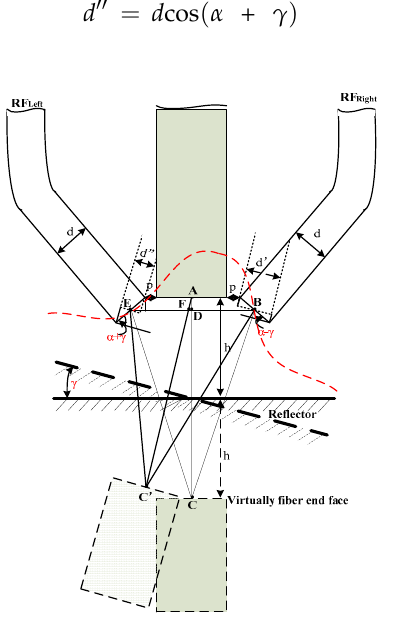
Figure 4. Geometric relationship when the reflection plane has an angle to the transmitting fiber.